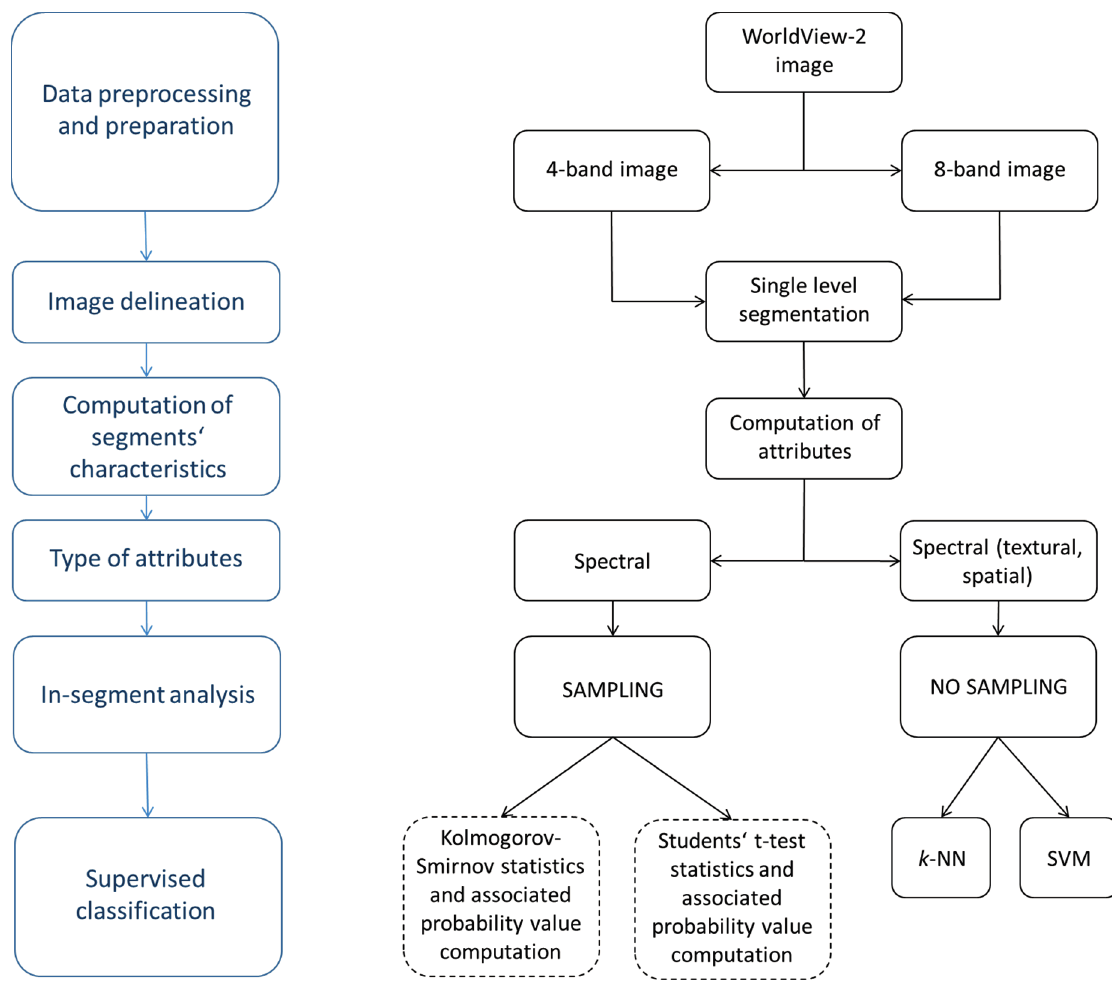
Figure 1. Process flow adopted in the